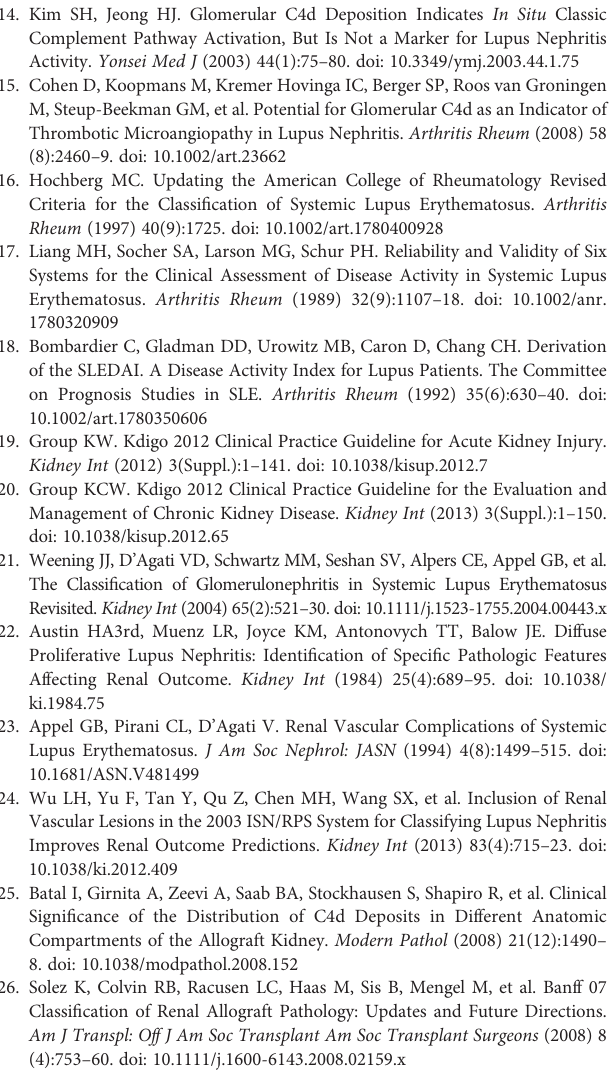
Supplementary Figure 1 | Flow chart of enrollment of lupus nephritis patients and the design of the study. Abbreviations: LN, lupus nephritis. Supplementary Table 1 | Analysis of co-deposition between arteriolar C4d and C1q, C3c and different immunoglobulins (IgG, IgMand IgA) in C4dpositive